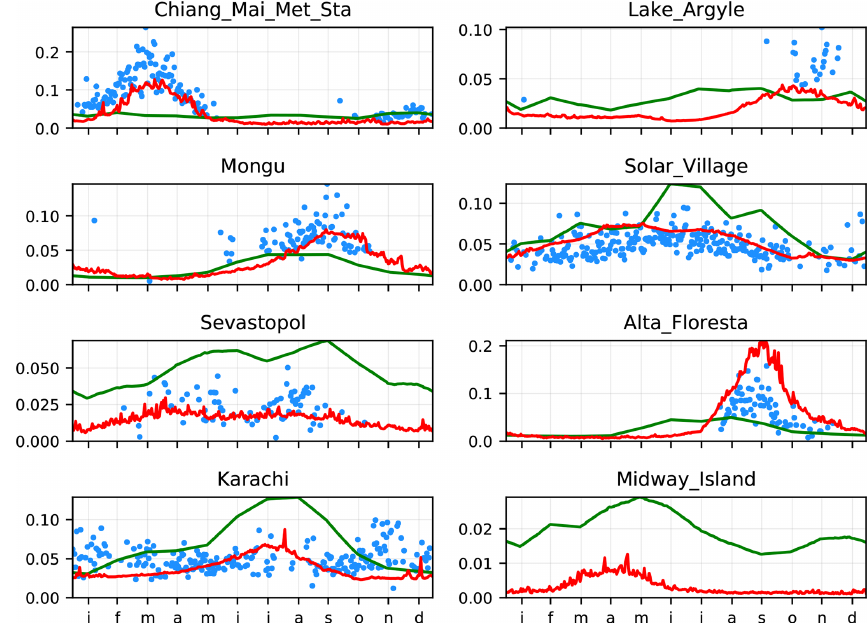
Figure 8. Comparison of daily mean AAOT at 500nm from the CAMS climatology (red line) and the TG97 climatology (green line), both as implemented in the ECMWF-IFS (see Appendix B for details) and AERONET data (blue dots). AERONET data are from L2.0, version 2, retrieval products (Holben et al., 2006; Dubovik et al., 2002) averaged over 5 years between 2006 and 2010. Please notice the different y axis for each